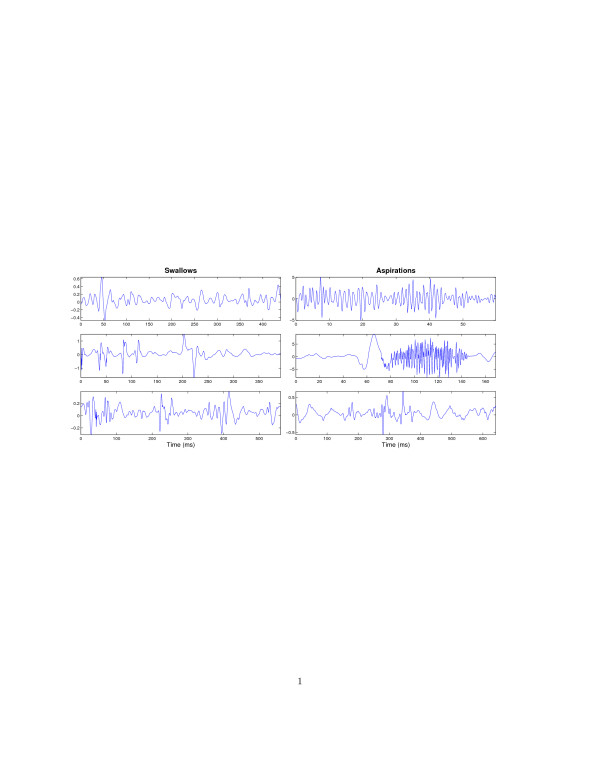
Sample swallow signals on the left and aspiration signals on the right. Note that swallows are typically longer in duration and dominated by low frequency components. Aspirations come in many flavours, some with noticeable high frequency elements (top and middle graphs on right side), but others with predominantly low frequency components (bottom right graph).